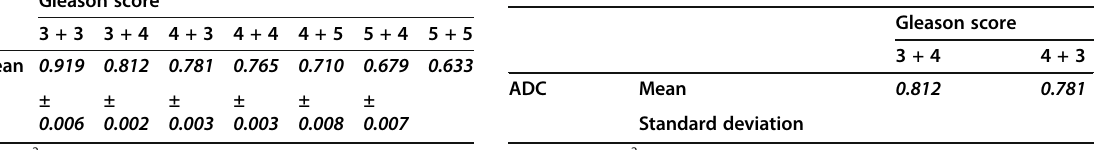
Multiple R = 0.96, R 2 = 0.93